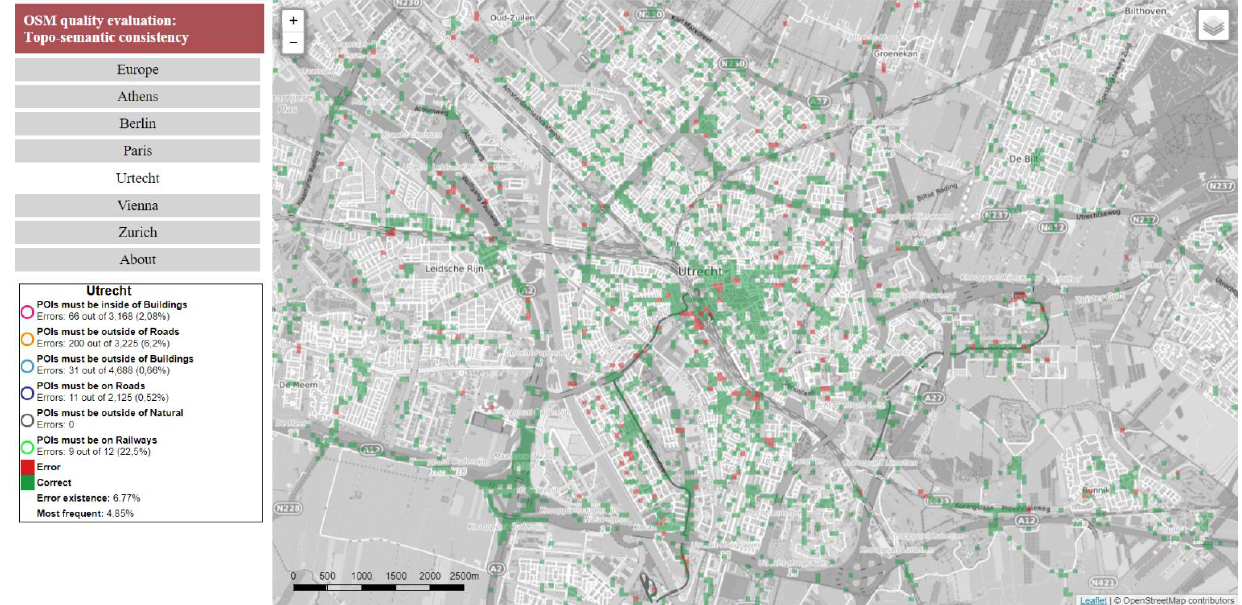
Figure A6. Consistency Grid (error existence) for Utrecht.